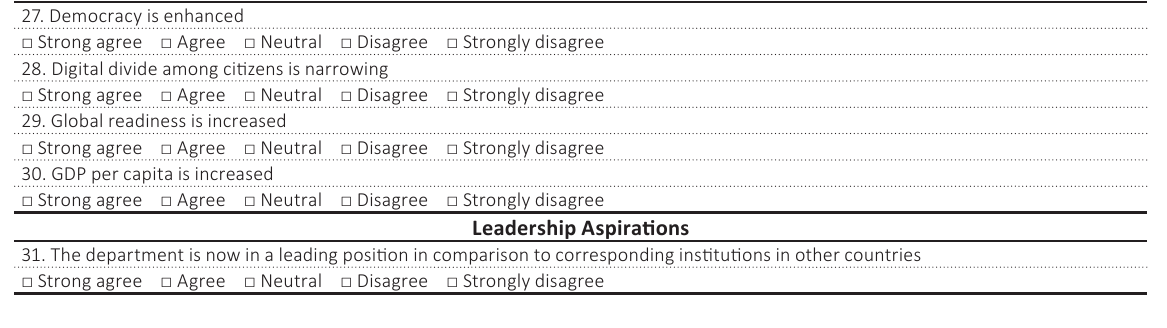
Table A1 (cont.). Questionnaire (Translated from